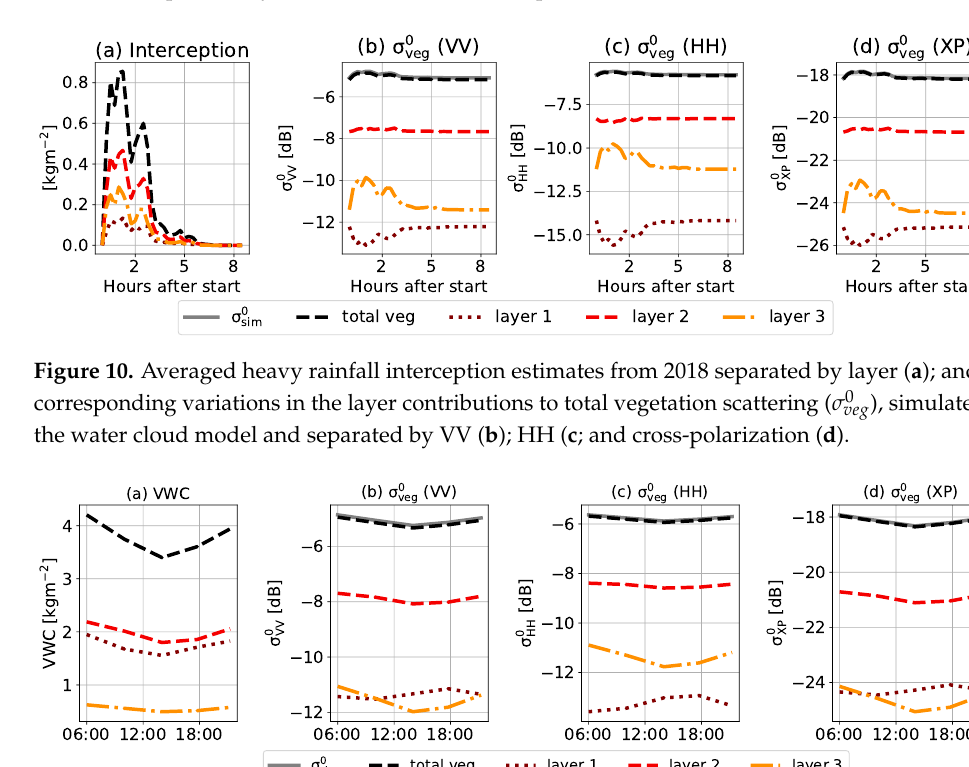
Figure 9. Averaged dew estimates from 2018 separated by layer ( a ); and the corresponding nocturnal variations in the layer contributions to total vegetation scattering ( σ 0 veg ), simulated by the water cloud model and separated by VV ( b ); HH ( c ); and cross-polarization ( d ).